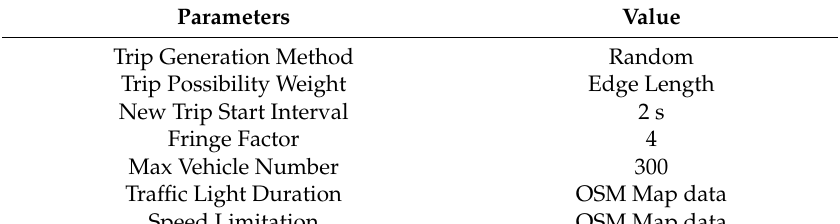
Table 1. Simulation parameters.